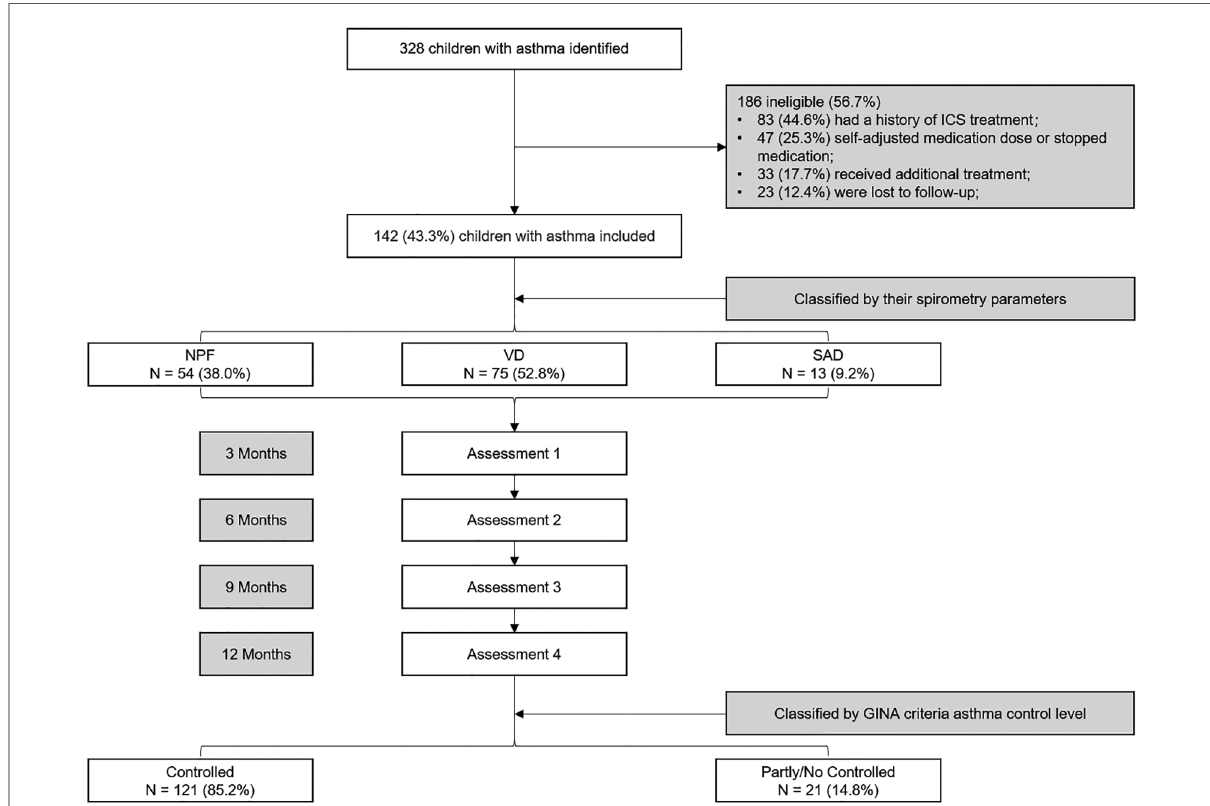
FIGURE 1 Flow diagram for the study design. NPF, normal pulmonary function phenotype; VD, ventilation dysfunction phenotype; SAD, small airway dysfunction